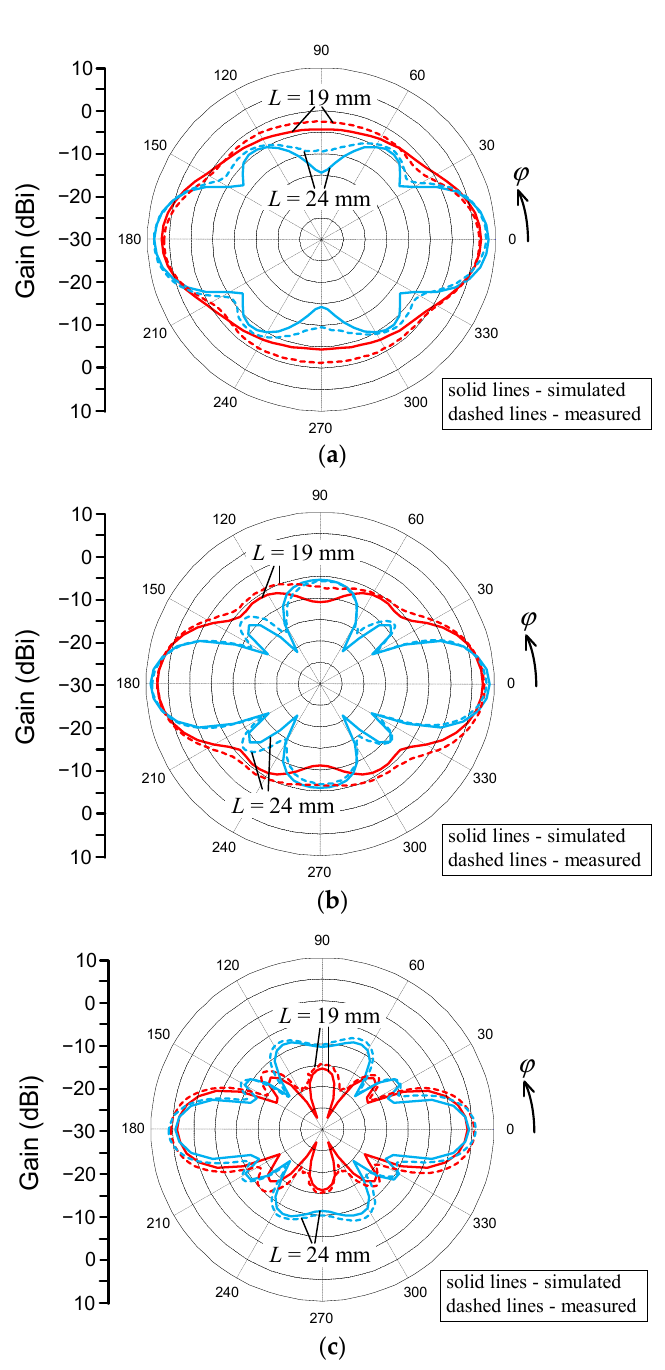
Figure 7. Simulated and measured radiation pattern of the proposed arrays in xy- plane at different frequencies: ( a ) 6 GHz; ( b ) 7.2 GHz; ( c ) 8.4 GHz.